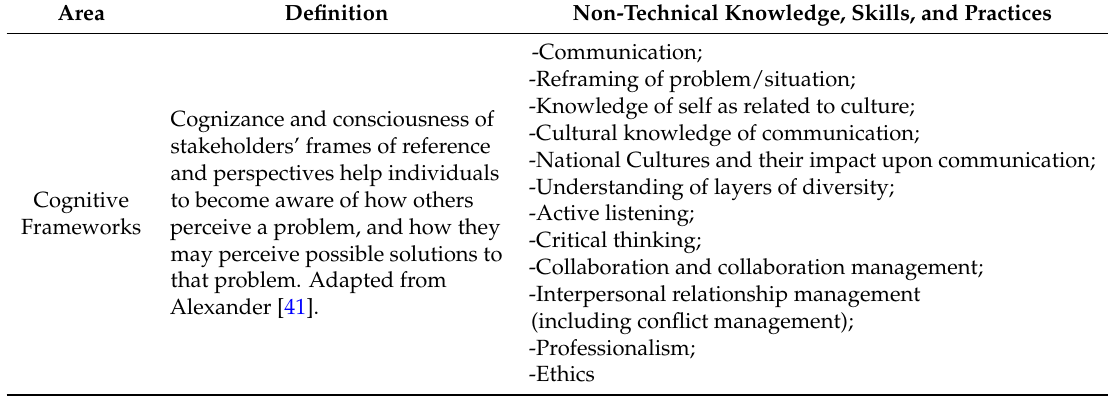
Table 4. Typology of non-technical skills for necessary for step 2: development-cognitive framing process within the IT project